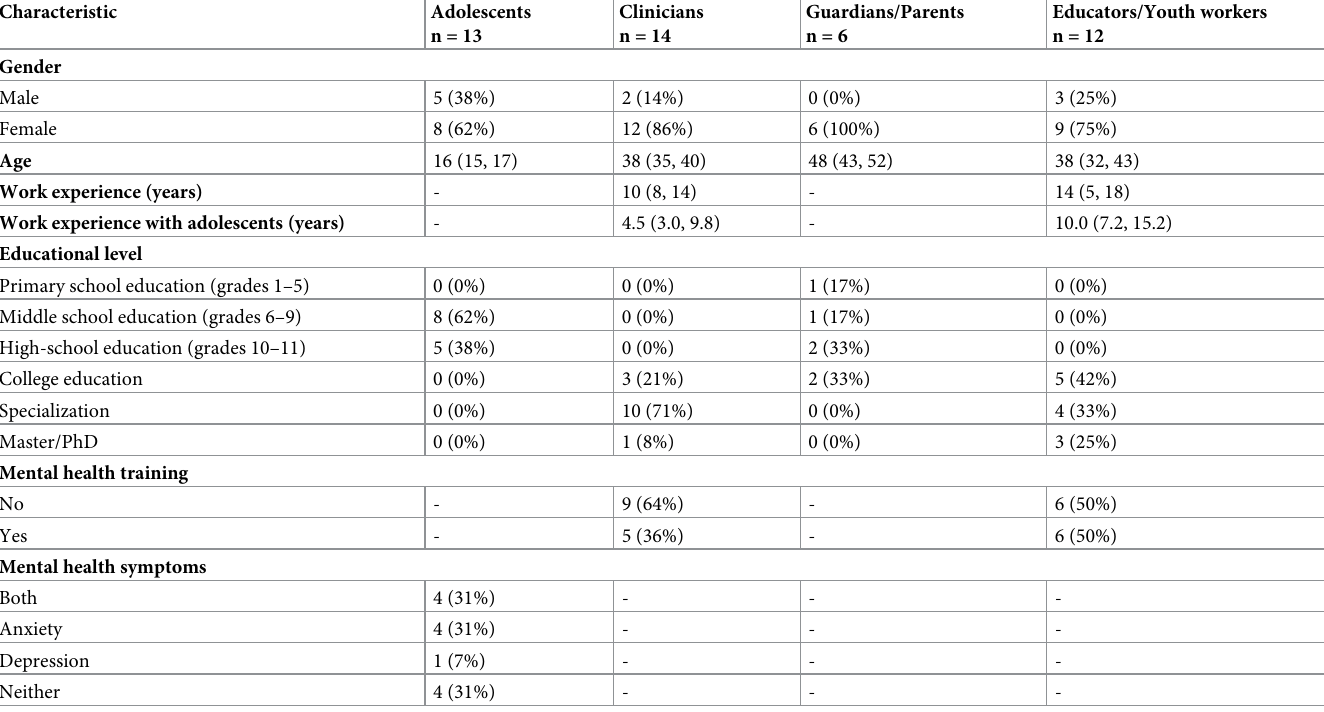
Table 1. Sociodemographic characteristics of